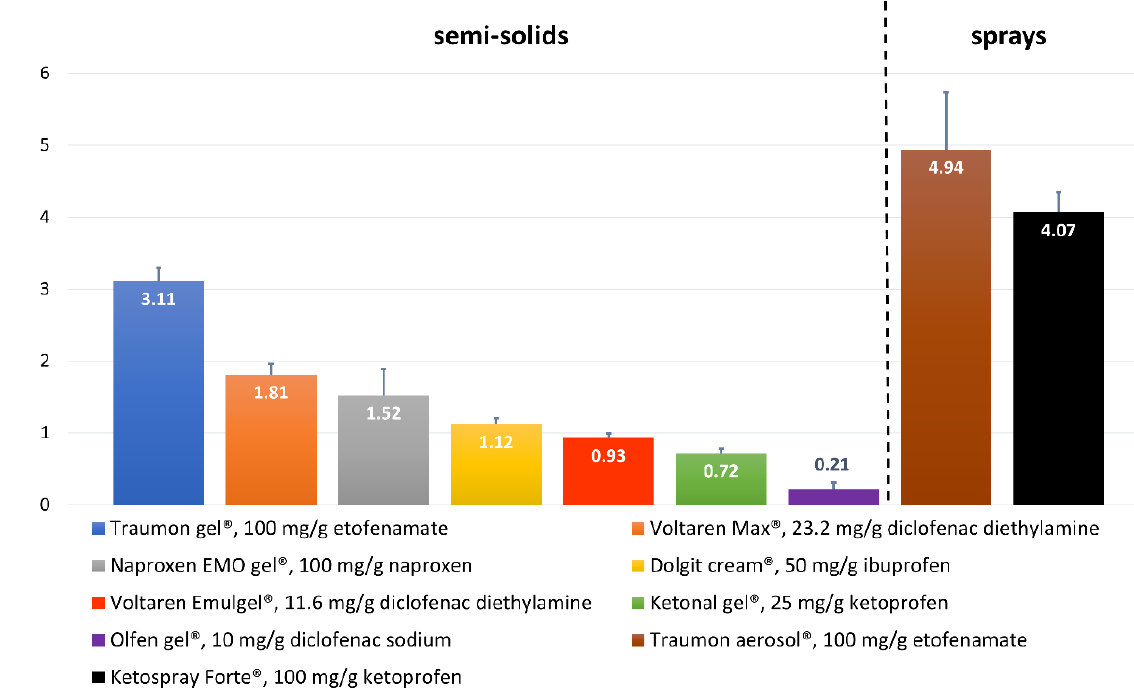
Figure 4. Comparison of NSAIDs permeation rates (mean ± SD; n = 6) from selected marketed topical formulations across Strat-M ® membrane obtained in optimized in vitro test conditions.